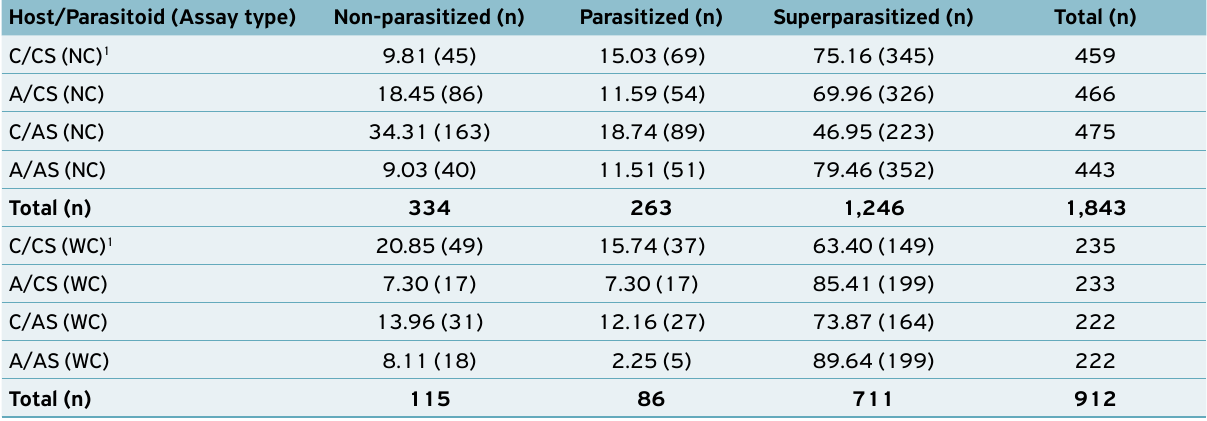
Table 1. Percent distribution of parasitism intensity among the pupae of Anastrepha fraterculus and Ceratitis capitata parasitized by Diachasmimorpha longicaudata